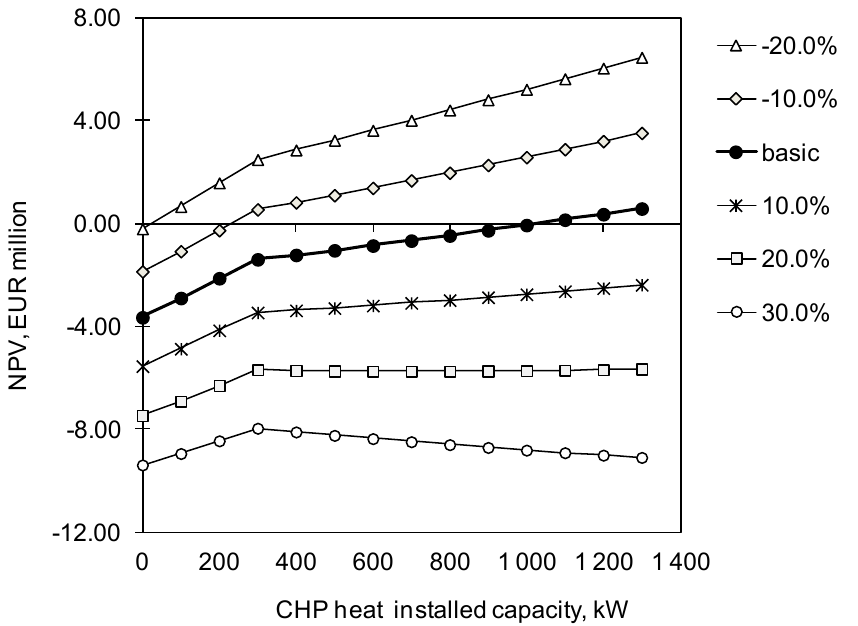
Figure 10. Sensitivity of the location of net present value (NPV(15)) function maximum for varying natural gas price.